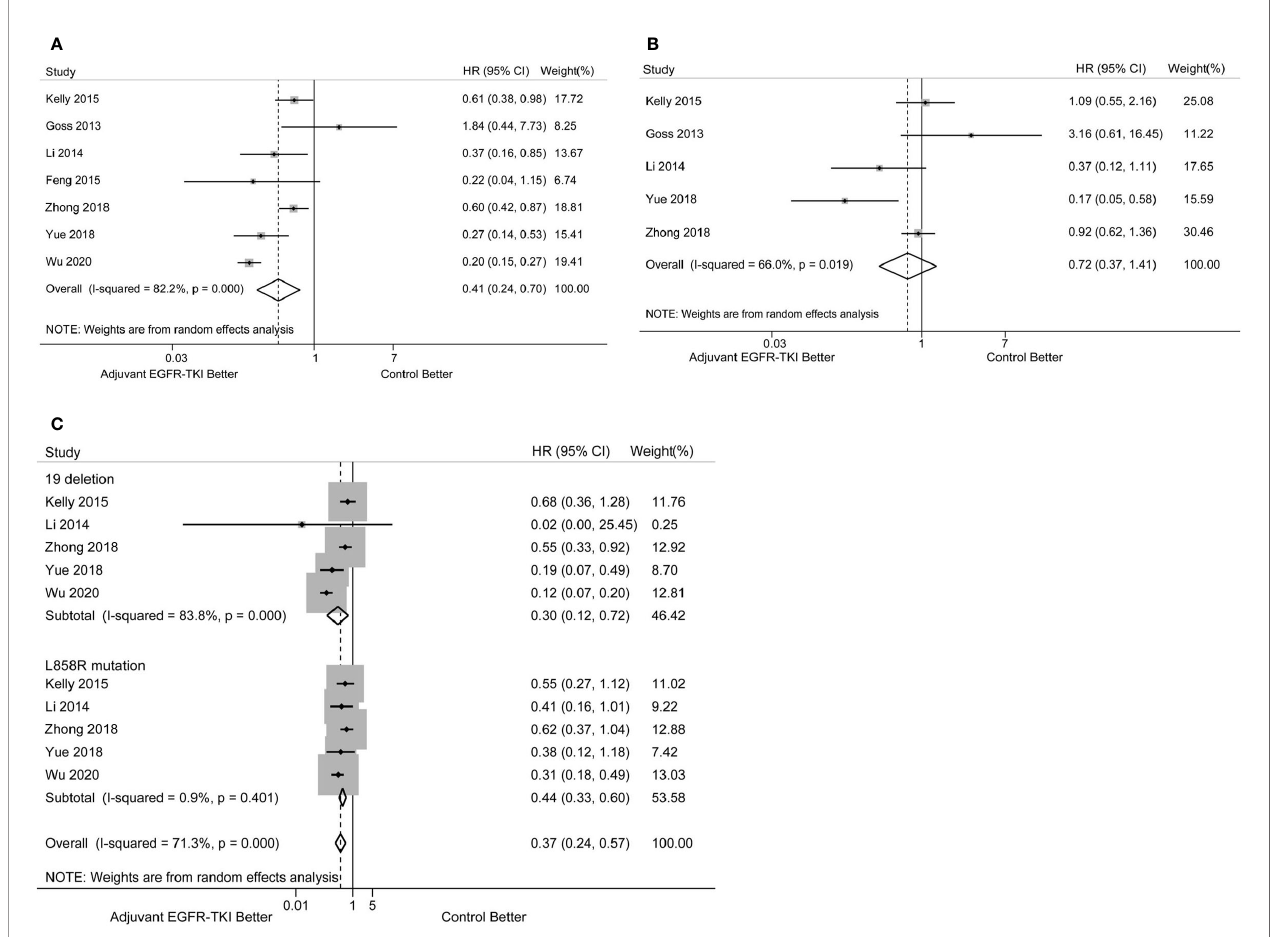
FIGURE 2 | (A) Forest plot of hazard ratio (HR) for disease-free survival (DFS) with adjuvant EGFR-TKI versus the control group in EGFR-mutant resected NSCLC patients. (B) Forest plot of HR for overall survival (OS) with adjuvant EGFR-TKI versus control arms in EGFR-mutant resected NSCLC patients. (C) Forest plot of HR for DFS with adjuvant EGFR-TKI versus the control group in NSCLC patients with EGFR exon 19 deletion and L858R